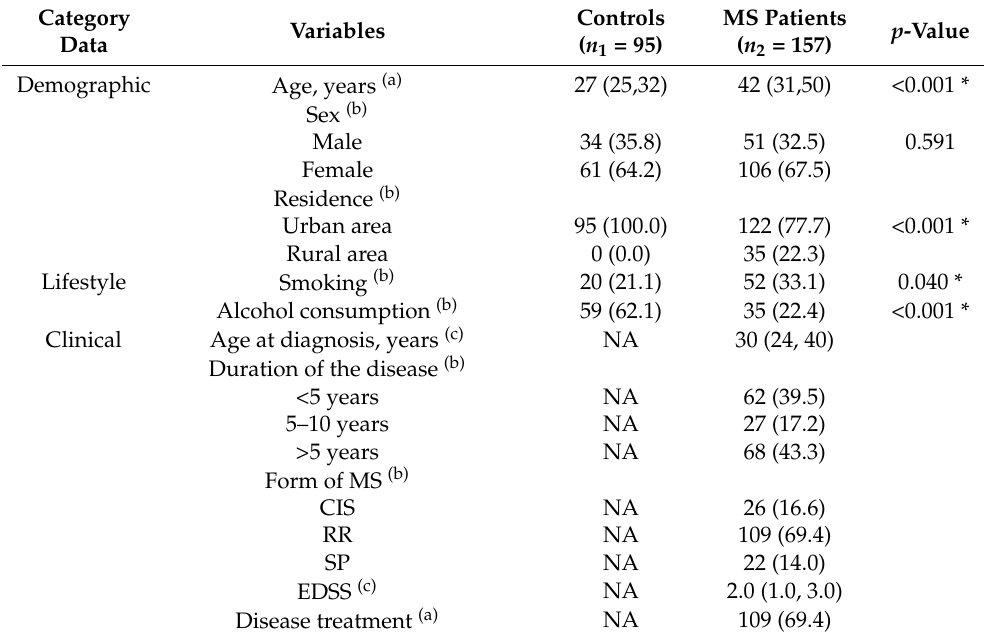
Table 2. Distribution of demographic, clinical and lifestyle characteristics in MS patients and controls.